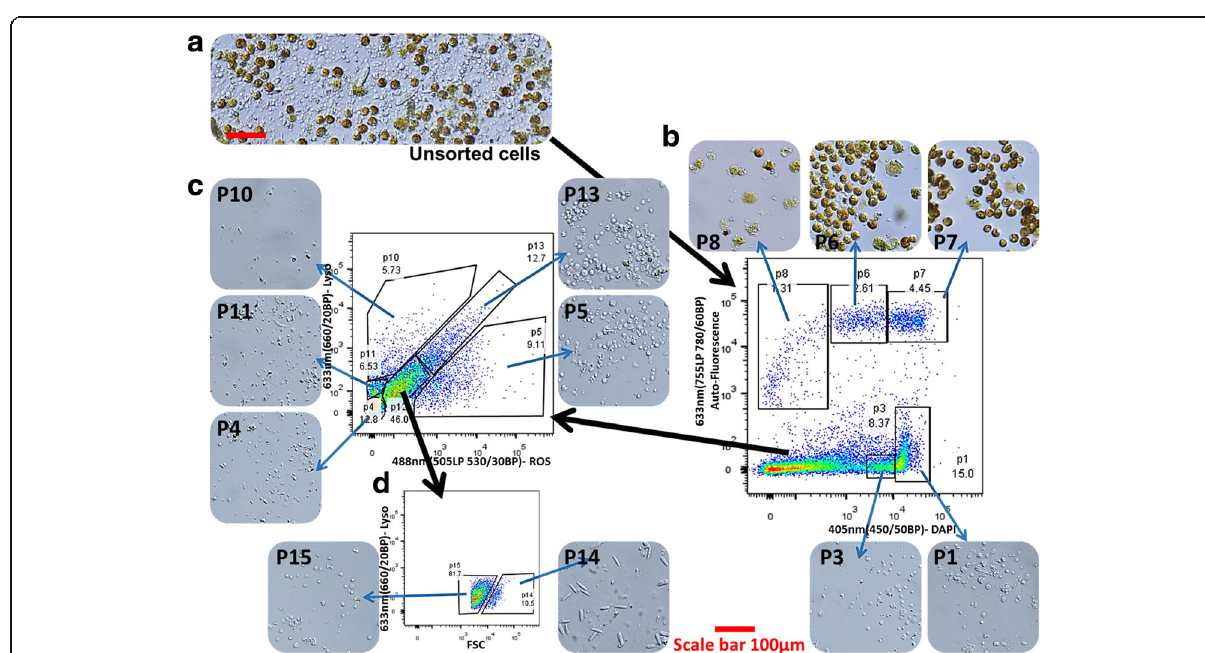
Fig. 4 12 coral cell populations sorted by FACS. P. damicornis cell suspension was labeled with DAPI, Cellrox, and LysoTracker Deep Red, analyzed and sorted on FACS ARIA II. Sorted cells were put on ibidi 18 microwell plate coated with poly-L-lysine, overnight at 4 o C prior to obtaining the cell images by light microscopy (image inserts). a ) Light microscopy image of unsorted cells. b ) After excluding cell debris by their intrinsic size (FSC) and granularity (SSC), we gated a two dimensional plot of the 633 nm (755LP 780/60BP) channel containing the Symbiodinium positive cells and DAPI stained cells in the 405 nm (450/50BP) channel. We sorted 3 Symbiodinium positive populations (upper panels, p6 – 8), and two positive populations for DAPI (lower inserts, p3 and p1). c ) Ungated cells in panel b were analyzed on two dimensional plot of 488 nm (505LP 530/30BP) channel- ROS and 633 nm (660/20BP) channel- LysoTracker. An additional 6 populations were differentiated by this panel (p4 – 5 and p10 – 13). d ) Population 12 (P12) was additionally separated into two populations on panel of size (FSC) and LysoTracker (APC) to P14 and P15. Notably, P14 is enriched for nematocyst cells. Red scale bar for all inserts = 100 μ